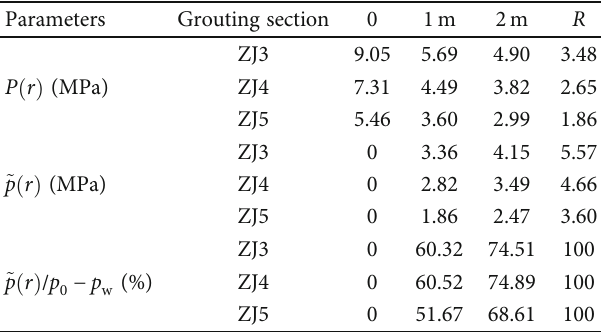
Figure 5: Pressure attenuation law of slurry. Table 3: Slurry pressure